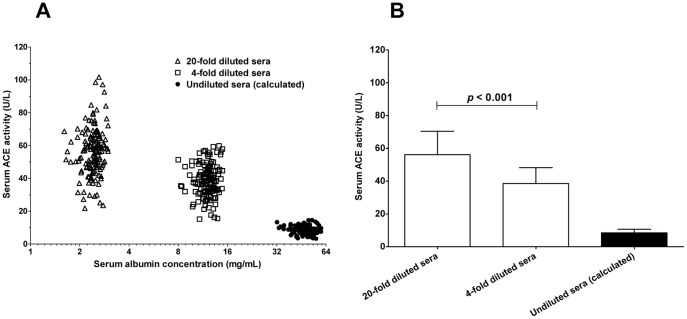
Serum ACE activity correlates with serum albumin concentration.Serum ACE activities (n = 151 patients) were determined at different dilutions (20-fold and 4-fold dilutions). The determined ACE activity values were plotted as a function of the actual serum albumin concentrations in the individual samples (A). Serum ACE activity values for undiluted sera were estimated based on the measured activity values at 20-fold dilution and the reported ACE-HSA inhibitory constant (IC50 = 5.7 mg/mL). These calculated ACE activity values were plotted as a function of the measured human serum albumin concentration in the individual serum samples (labelled as undiluted sera). Values are also given as the mean and SD of the individual determinations (B). There was a significant difference (unpaired t-test) between the values measured at 20-fold and 4-fold dilutions (indicated).